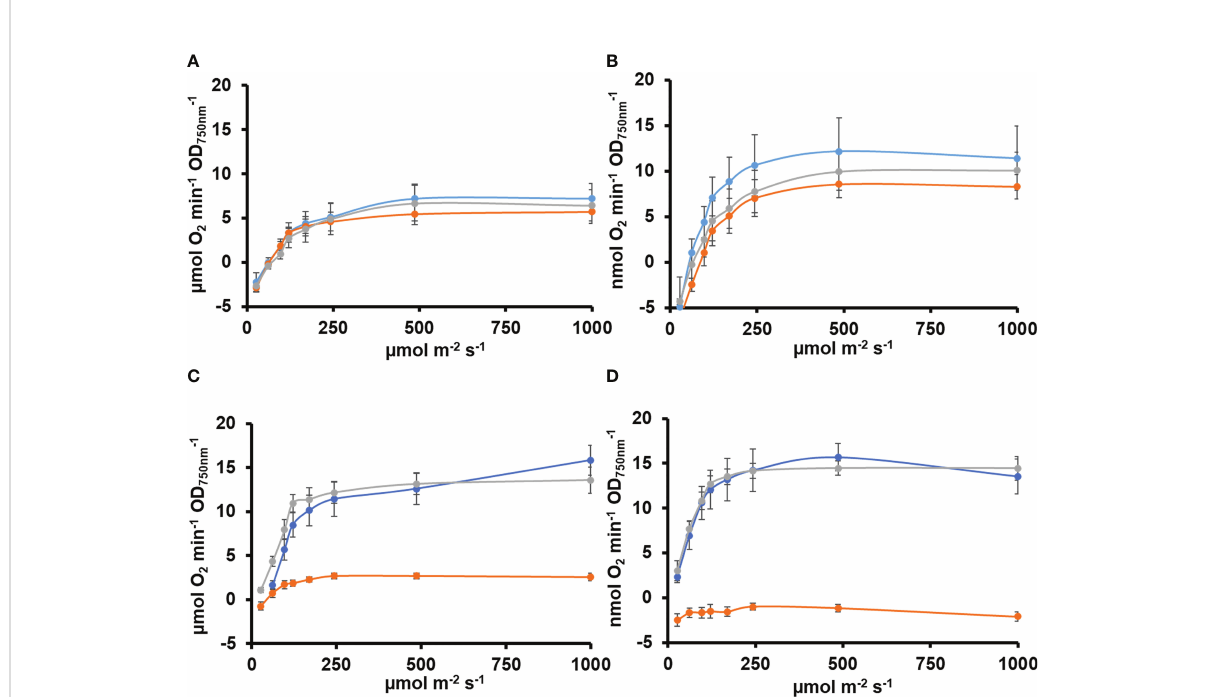
FIGURE 2 Oxygen evolution in WT, D S/F, and D F strains in different trophic regimes. (A) Oxygen evolution measured using a Clark electrode at increasing light intensities in exponential growing cultures (OD 750nm = 0.5 – 1) of WT ( ○ ), D S/F ( ○ ), and D F ( ○ ) grown in BG11C + 10 mM glucose for 24 h. Data are the mean ± SE of at least three biologically independent experiments. (B) Oxygen evolution measured using a Clark electrode at increasing light intensities in exponential growing cultures (OD 750nm = 0.5 – 1) of WT ( ○ ), D S/F ( ○ ), and D F ( ○ ) grown in BG11C + 10 mM glucose for 48 h. Data are the mean ± SE of at least three biologically independent experiments. (C) Oxygen evolution measured using a Clark electrode at increasing light intensities in exponential growing cultures (OD 750nm = 0.5 – 1) of WT ( ○ ), D S/F ( ○ ), and D F ( ○ ) grown in BG11C + 10 mM glucose and shifted to BG11C for 24 h. Data are the mean ± SE of at least three biologically independent experiments. (D) Oxygen evolution measured using a Clark electrode at increasing light intensities in exponential growing cultures (OD 750nm = 0.5 – 1) of WT ( ○ ), D S/F ( ○ ), and D F ( ○ ) grown in BG11C + 10 mM glucose and shifted to BG11C for 48 h. Data are the mean ± SE of at least three biologically independent